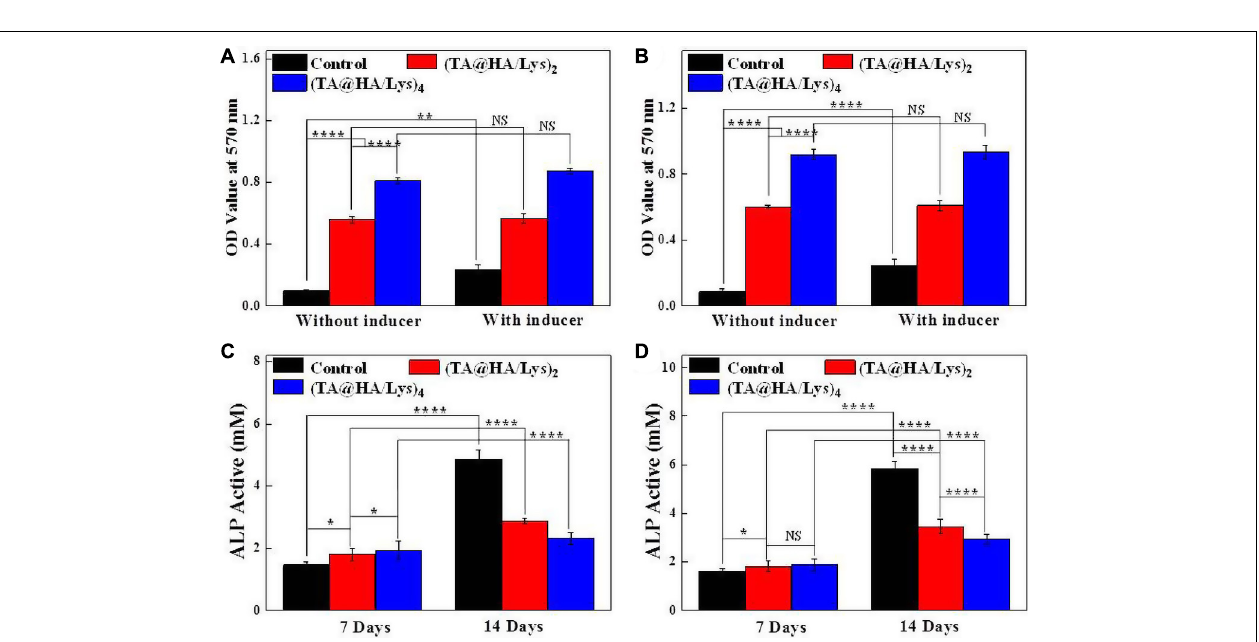
FIGURE 8 | OD values at 570 nm after extracting the Alizarin Red S stained for evaluating the osteoblast mineralization of (A) MC3T3-E1 cells and (B) DPSCs cultured on glass coverslips as control, (TA@HA/Lys) 2 and (TA@HA/Lys) 4 films with/without induction solution for 14 days. Alkaline phosphatase (ALP) activities of (C) MC3T3-E1 cells and (D) DPSCs cultured on glass coverslips as control, (TA@HA/Lys) 2 and (TA@HA/Lys) 4 films for 7 and 14 days. * p < 0.05, ** p < 0.01, **** p <